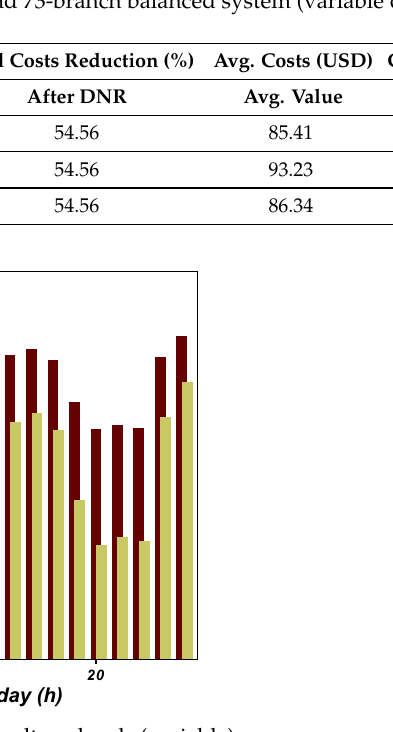
Figure 7. 69-bus and 73-branch system voltage levels